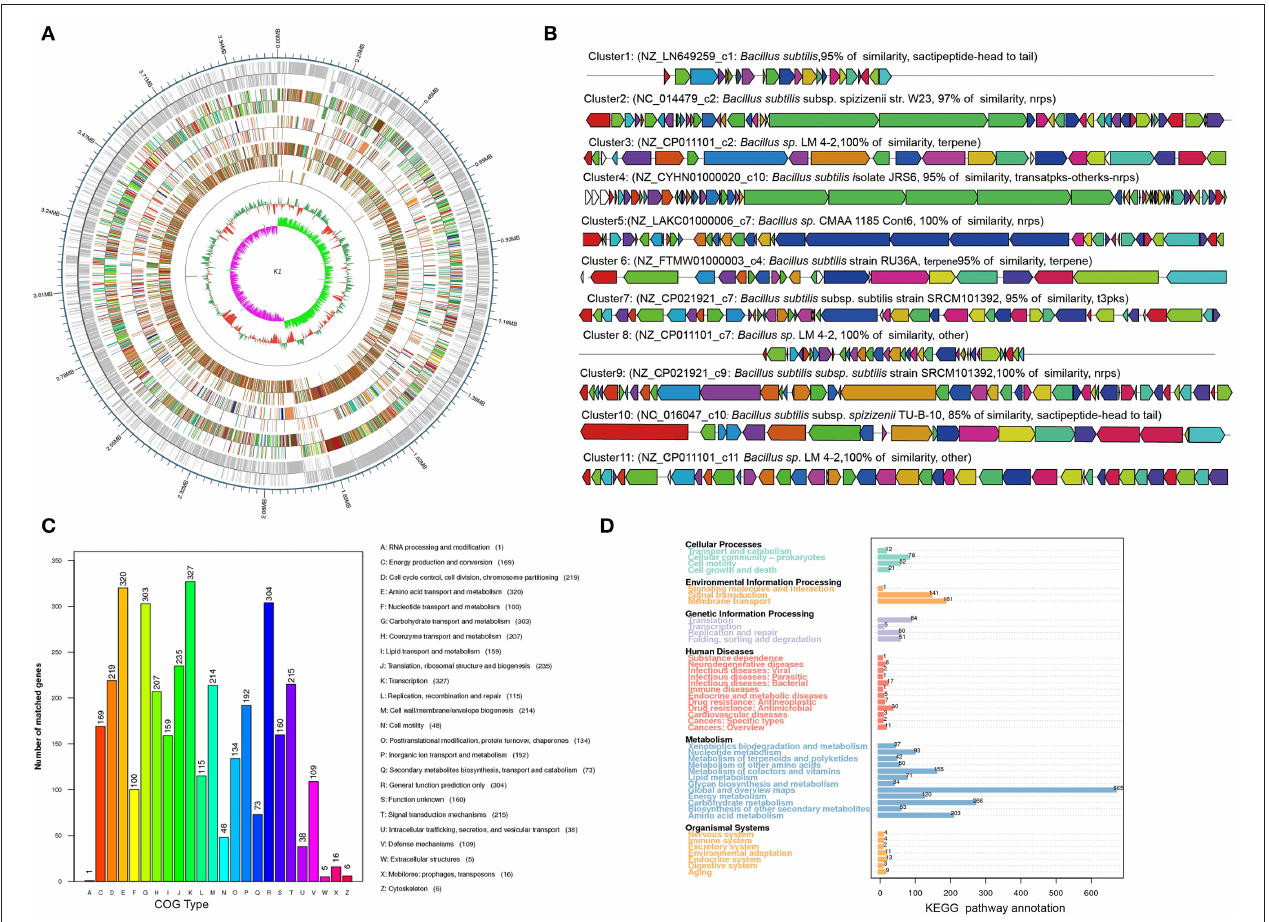
FIGURE 4 | Genome information and function annotation of Bacillus K1. (A) Circular map of Bacillus K1 genome. From outside to center, ring 1 is the mark of genome size. Rings 2 and 3 represent coding genes on the forward/reverse strand. Rings 4 and 5 represent coding sequence (CDS) on the forward/reverse strand. Different colors indicate the functional category of different Clusters of Orthologous Groups (COGs) of CDS. Rings 6 and 7 represent CDS on the forward/reverse strand. Different colors indicate the functional category of different Kyoto Encyclopedia of Genes and Genomes (KEGG) pathway. Rings 8 and 9 represent CDS on the forward/reverse strand. Different colors indicate the functional category of different Gene Ontology (GO) function annotation. Ring 10 is tRNA and rRNA. Ring 11 shows the G + C content. The outward green part indicates that the guanine–cytosine (GC) content of this region is higher than the average GC content of the whole genome. The inward purple part indicates that the GC content of this region is lower than the average GC content of the whole genome. (B) Biosynthesis gene clusters demonstrating more than 90% similarity with the known sequences. (C) COG annotation of Bacillus K1 genome. (D) KEGG annotation of Bacillus K1